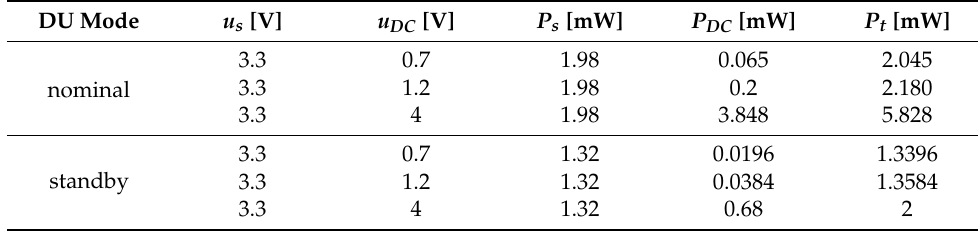
Table 2. Power consumption of the driver